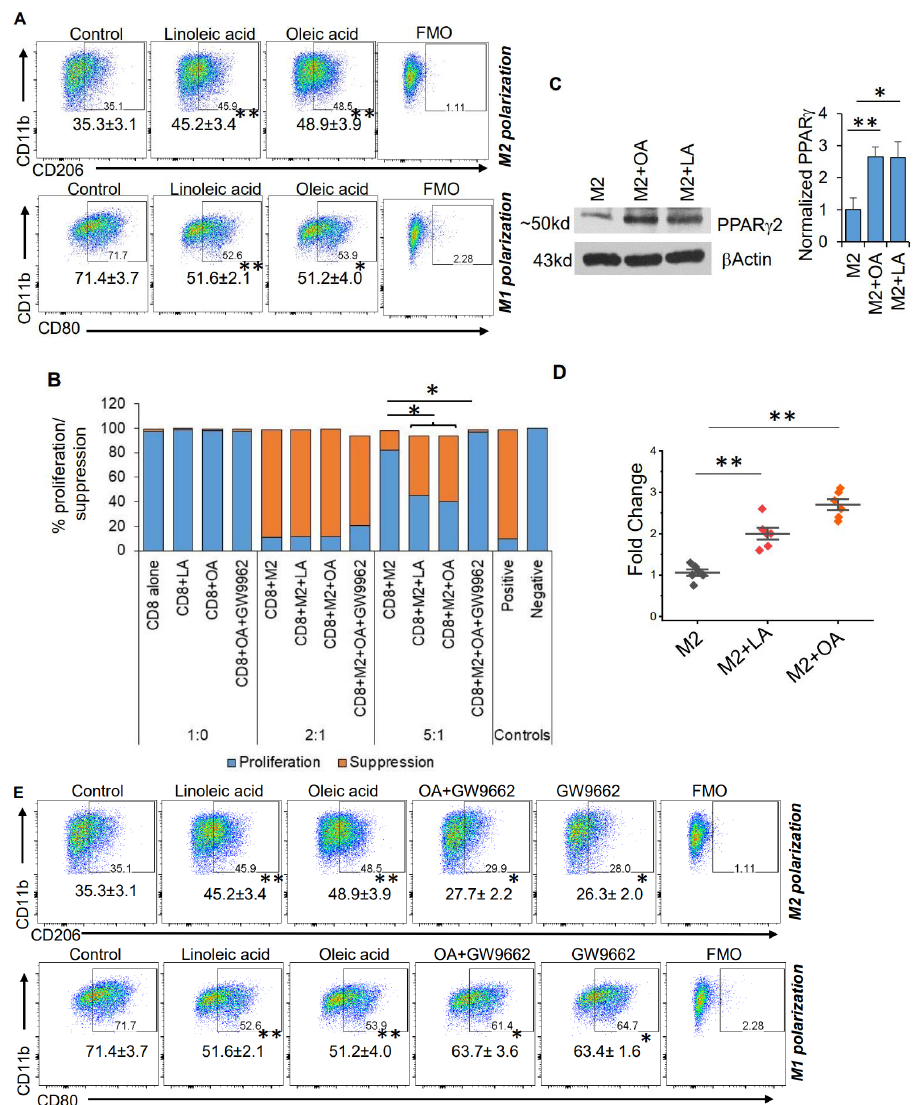
Figure 3. Fatty acids modulate macrophage polarization. ( A ) Myeloid cells were obtained from the bone marrow of C57BL/6 mice and polarized towards M2 macrophages or M1 macrophages ± the indicated unsaturated fatty acid (linoleic acid [LA] 200 mM; oleic acid [OA] 200 µM) and analyzed via flow cytometry. Numbers represent mean±SD from a minimum of 3 different experiments. ( B ) To analyze the functional aspect (immune suppressive ability) of M2 macrophages, mouse-derived M2 cells were generated as described in ( A ) and polarized with indicated agents. Splenocytes from C57BL/6 mice were used for isolating CD8+ T cells with magnetic bead sorting. CFSE labeled CD8+ T cells were activated using plate-bound anti-CD3/CD28 antibodies for three days in the presence or absence of M2 cells. Data are represented as a bar graph demonstrating CFSE dilution (prolifer- ation) or suppression. CFSE labeled CD8+ T cells without stimulation (anti-CD3/CD28 antibody) were used as a positive control of suppression. Unlabeled CD8+ T cells were used as a negative control for proliferation. ( C ) Mouse bone-marrow-derived M2 macrophages were cultured in ± LA (200 mM) or OA (200 µM) and analyzed for indicated proteins using Western blot. Bar graph (n = 3 experiments) represents PPAR γ protein normalized to β Actin. ( D ) PPAR γ transcriptional activity was evaluated in M2 macrophages cultured ± LA (200 mM) or ±OA (200 µM). ( E ) Myeloid cells were obtained from the bone marrow of C57BL/6 mice and polarized towards M2 macrophages or M1 macrophages ± the indicated unsaturated fatty acid (linoleic acid [LA] 200 mM; oleic acid [OA] 200 µM) ± PPAR γ antagonist GW9662 and analyzed using flow cytometry. Data are representative of a minimum of three experiments. *: p < 0.05, **: p < 0.005 . Mitigating KD-induced changes in macrophage polarization through CSF-1 inhi- bition potentiates anti-tumor activity. Although we demonstrated clear anti-tumor activity following a KD in GBM, we hy- pothesized that parallel increases in immunosuppression through M2 macrophage polar- ization mitigated the therapeutic potential of this diet. Macrophages require colony-stim- ulating factor 1 (CSF-1) to attain an M2-like immunosuppressive phenotype, and CSF-1 receptor inhibition represents a promising strategy to attenuate M2-like macrophages in GBM [34,35]. We therefore sought to determine if CSF-1 inhibition could enhance the anti- tumor activity of a KD by normalizing this paradoxical increase in immune suppression. To test this, we performed in vivo studies evaluating mice fed a SD or KD in combination with and without the CSF-1R inhibitor BLZ945. Similar to our initial studies described above, immunophenotyping of tumors extracted from mice fed a KD demonstrated lower levels of lymphocytes and macrophages and an increase in microglial cells (Figure S4A,B). The addition of BLZ945 alone or in combination with a KD did not appear to influence these profiles. Although CSF-1R inhibition did not regulate levels of total macrophages in the tumor microenvironment, intriguingly, it did demonstrate the capacity to normalize KD-induced changes in macrophage polarization. Specifically, previously described KD- induced increases in M2-like macrophages and decreases in M1-like macrophages were normalized when combined with BLZ945 (Figure 4A). Although no changes in CD4 or CD8 cells were observed (Figure S4C), a significant increase in M1-like macrophages with